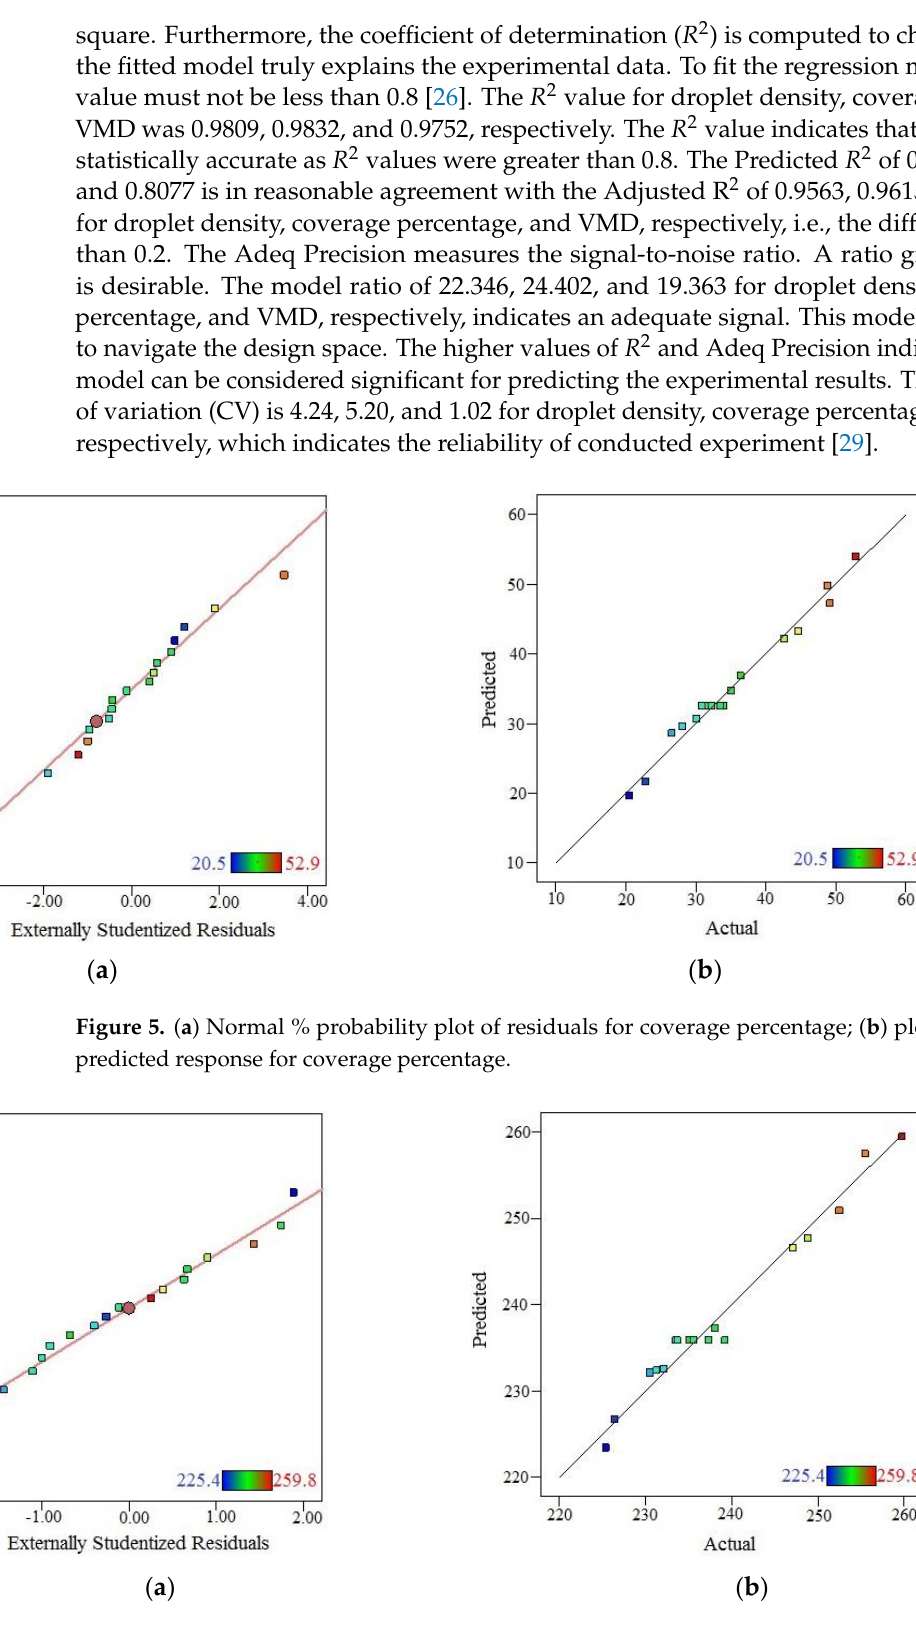
Figure 6. ( a ) Normal % probability plot of residuals for VMD; ( b ) plot of actual vs. predicted re- sponse for VMD. for